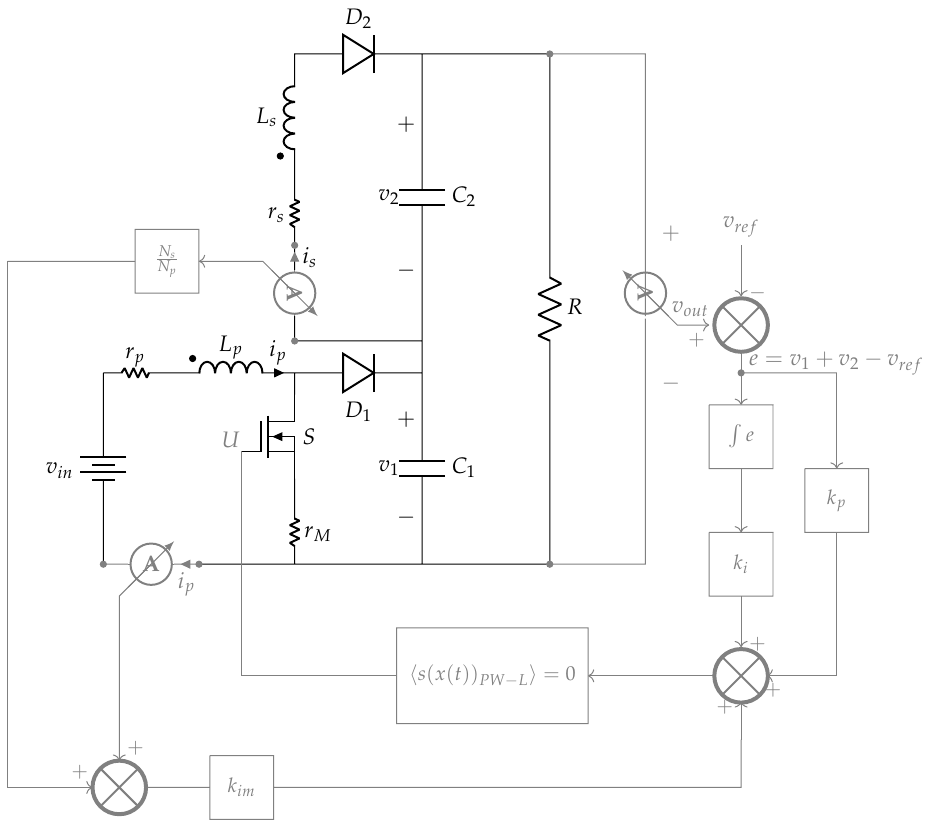
Figure 1. Boost-flyback converter with Zero Average Surface (ZAS)